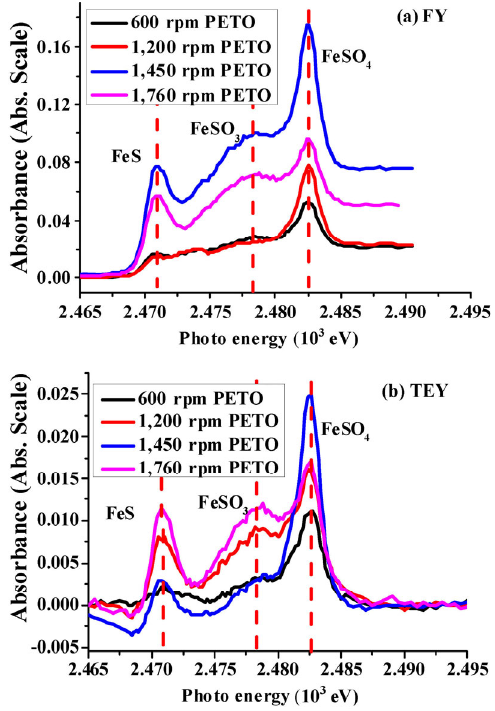
Fig. 4 Sulfur K-edge FY mode (a) and TEY mode (b) XANES spectra for DPS-tribofilm with different rotary